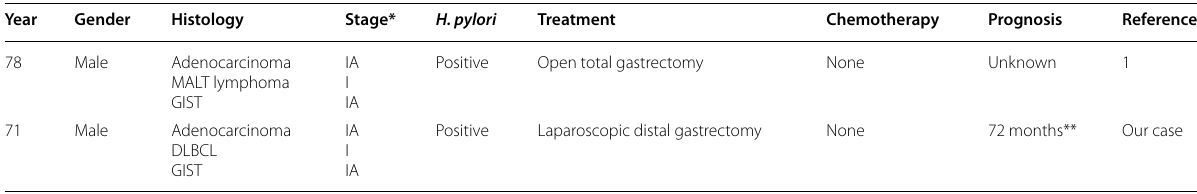
*8th TNM classification **Recurrence-free